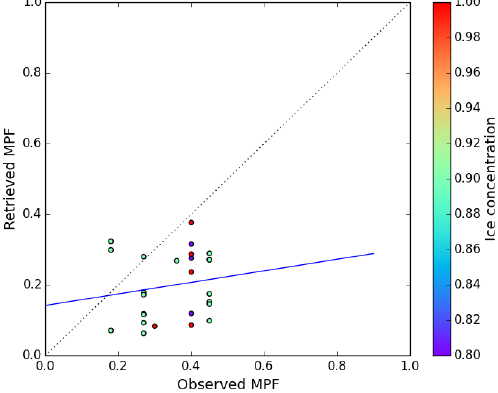
Figure 16. An example image made from the bridge of RV Po- larstern during the TransArc 2011 (ARK XXVI3) on 4 Septem- ber 2011 within the course of ASPeCt observations. The pond frac- tion estimated during the cruise is 0.5. The satellite retrieved pond fraction for such cases will be significantly smaller because of high albedo of frozen over snow-covered ponds. Image source (Nicolaus et al., 2012).